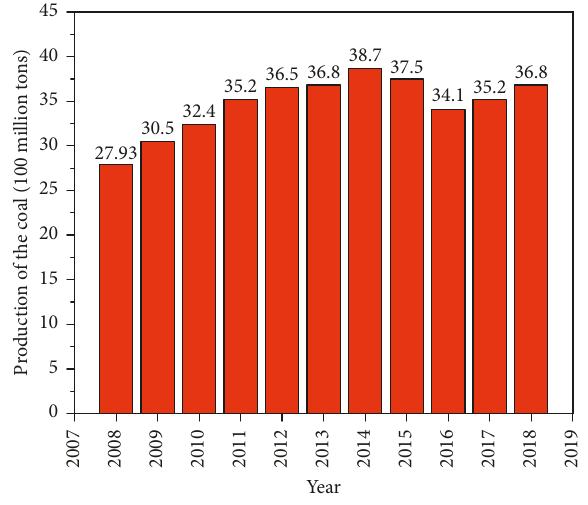
Figure 1: Energy production of China.